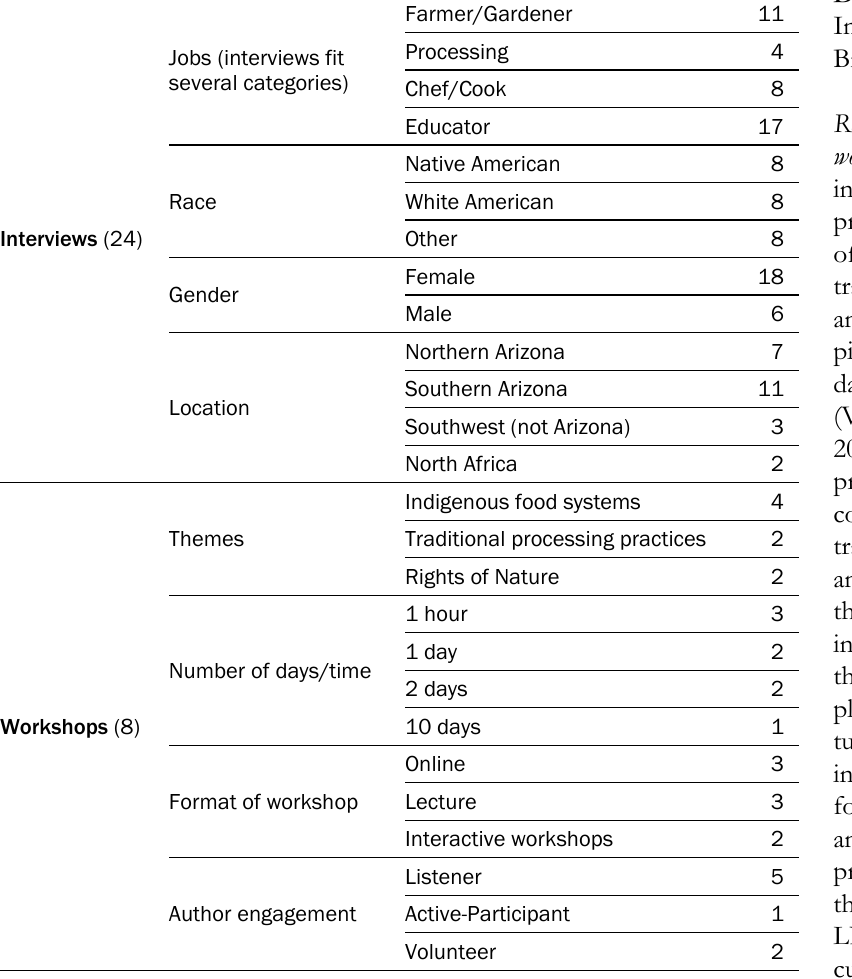
Table 2. Interviews Conducted and Workshops Attended in the Course of the Research